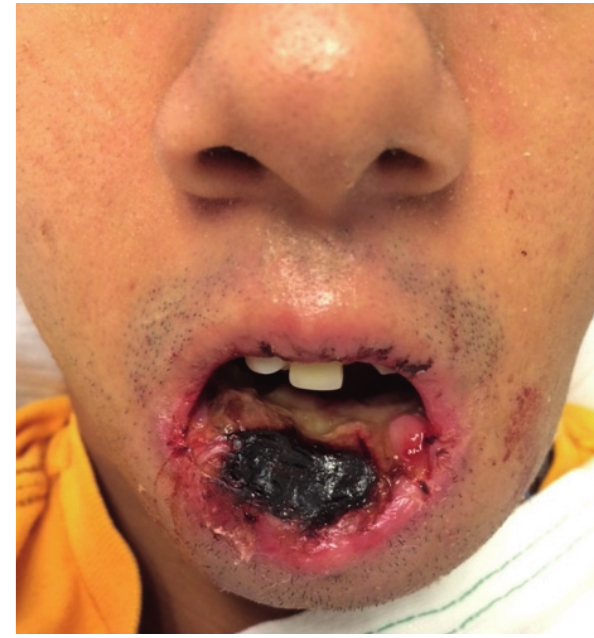
Fig. 4. The patient developed large pharyngeal blood clots after the first operation. The picture was taken before debridement and